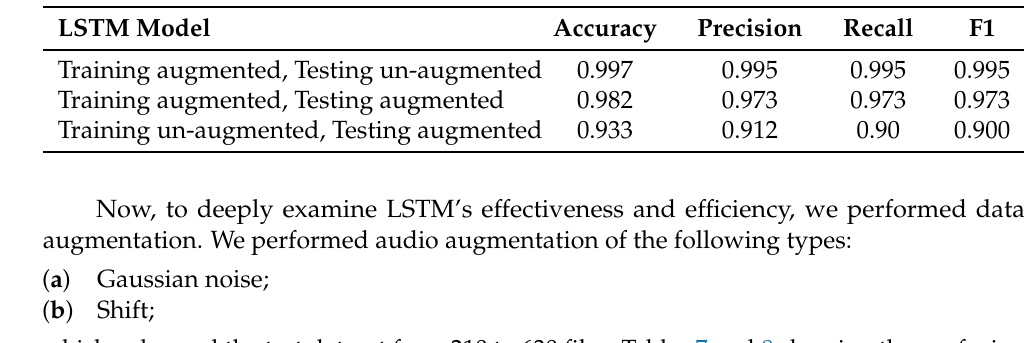
Table 6. Performance evaluation using all variants of LSTM with 8.5 s split time.